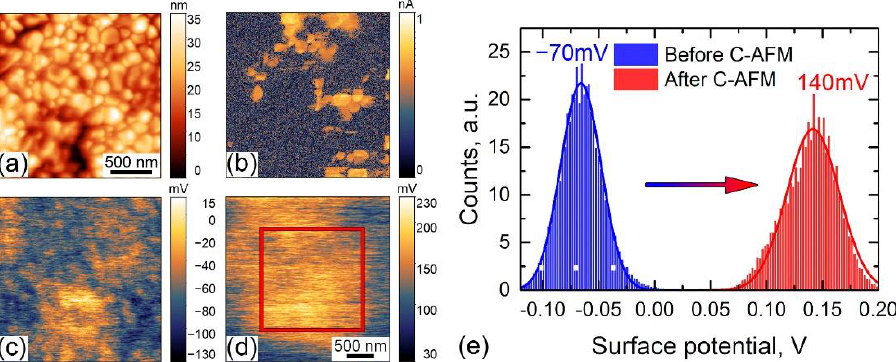
Figure 9. ( a ) Topography, ( b ) current distribution after RS, and surface potential distribution in BFO film ( c ) before and ( d ) after RS, ( e ) histograms of surface potentials. The red square—is a scanning region at ( a – c